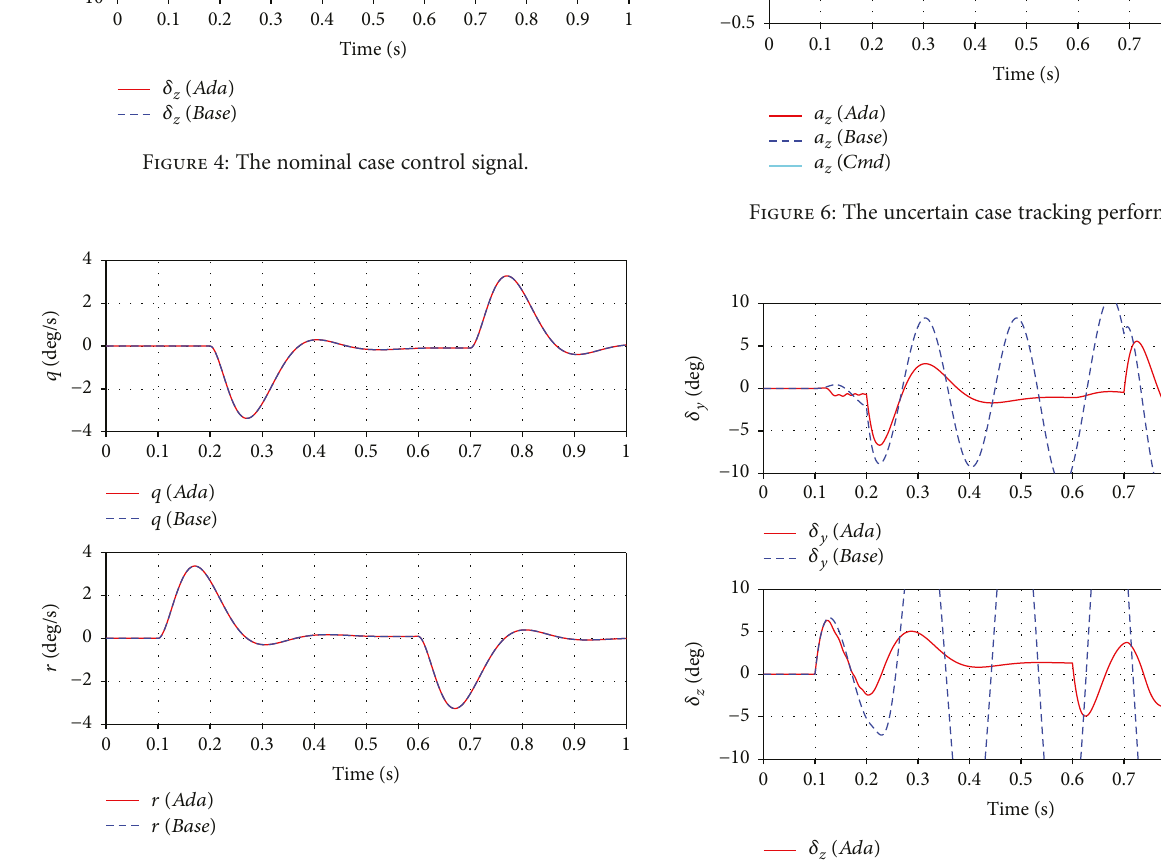
Figure 5: The nominal case angular rates.